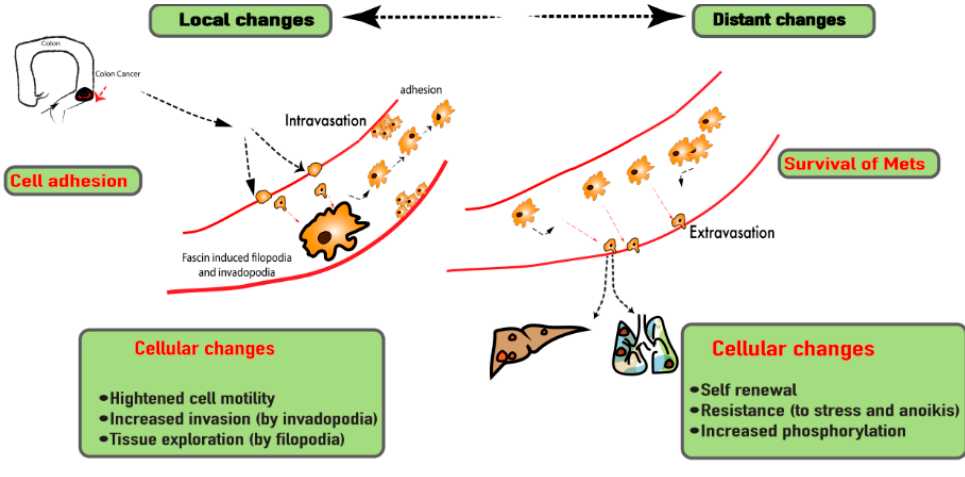
Figure 6. Mechanism and role of fascin-1 in the tumor progression.